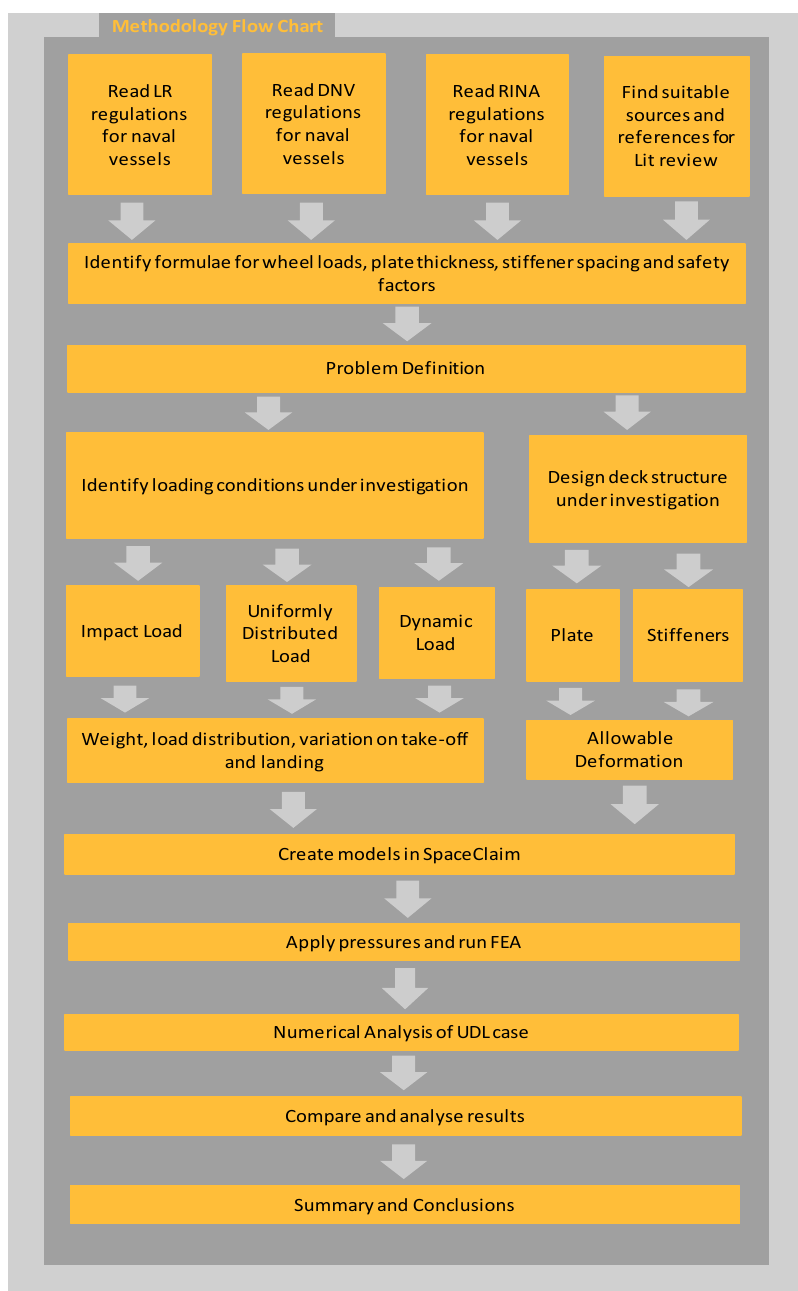
Figure 1. Methodology flow chart.